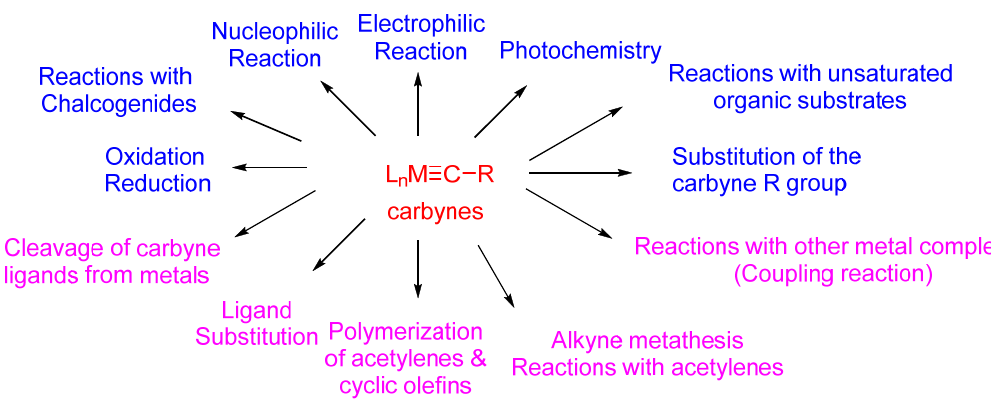
Figure 1. Reactions of acyclic carbynes.